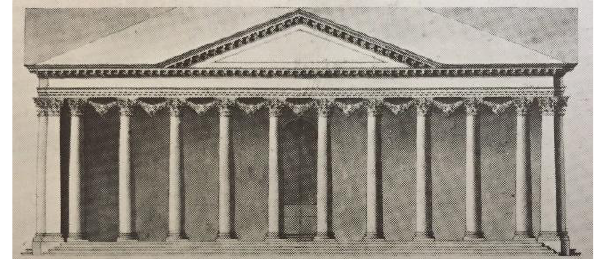
Figure 3. A. Visentini, Restituzione ideale della loggia per l’ingresso di Enrico III a Venezia, 1756, British Museum, Londra: facade.